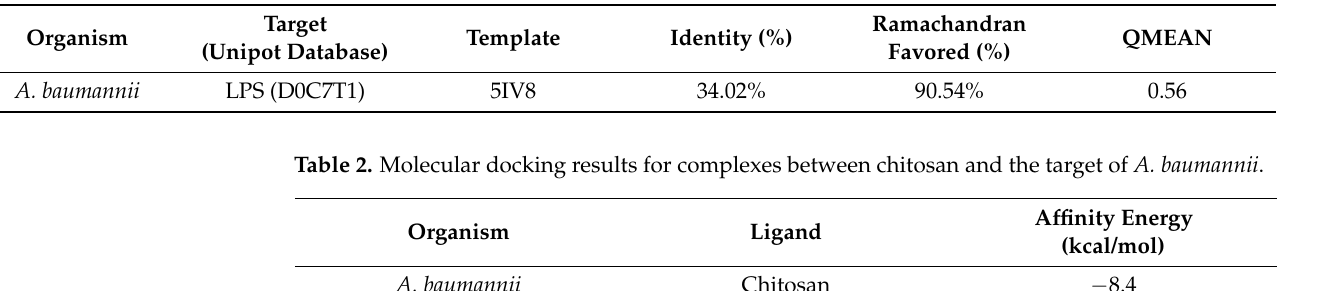
Table 1. The target model of the A. baumannii lipopolysaccharide was used to analyze the molecular docking with chitosan.